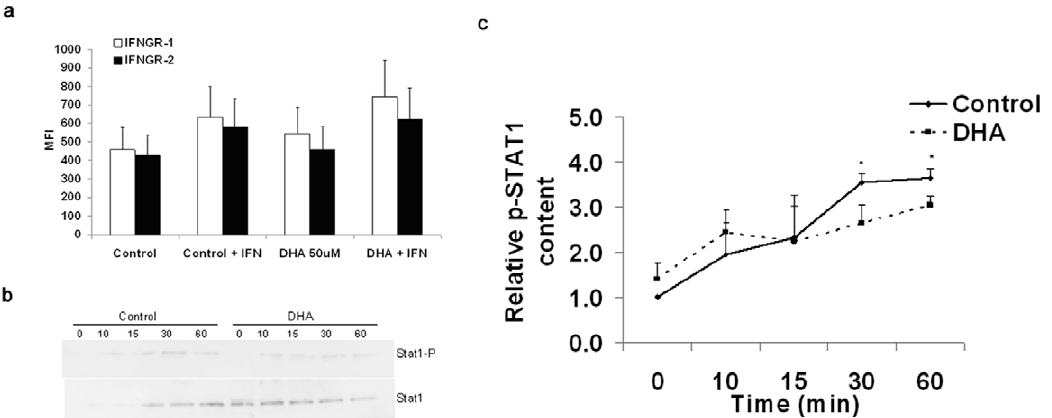
Figure 6. DHA does not affect the expression of IFN c R1 & R2 but decreases STAT1 phosphorylation in non-infected J774A.1 cells primed with IFN c . Macrophages were incubated with 50uM DHA for 24 hours and then stimulated with or without IFN c (100 U/ml) for 24 h. The cells were then labeled with PE-conjugated antibodies to IFN c R1 and IFN c R2 and intensity of fluorescence was quantified by flow cytometry, as described in the Materials and Methods . Cells were seeded at a density of 500,000 cells/well. a. Quantitative data represent the Mean Fluorescence Intensity (MFI) of PE fluorescence (mean 6 SEM; n=9) for IFN c R1 and IFN c R2. No significant differences were found between DHA and control groups. To measure STAT1 phosphorylation, cells were incubated with 50uM DHA for 24 hours and then stimulated with IFN c (100 U/ml) from 0–60 min. The cells were then lysed in lysis buffer, loaded onto an SDS-PAGE gel, and transferred to a PVDF membrane as described in the Materials and Methods . b. Representative immunoblots probed for anti-phospho STAT1 (p-STAT1) or total STAT1 proteins. c. Quantitative data of the relative expression of p- STAT1 to total STAT1 (mean 6 SEM; n=6–9). Significant differences were found between control and DHA groups at 30 min and 1 h. Data are representative of three independent experiments. Abbreviations used: DHA, docosahexaenoic